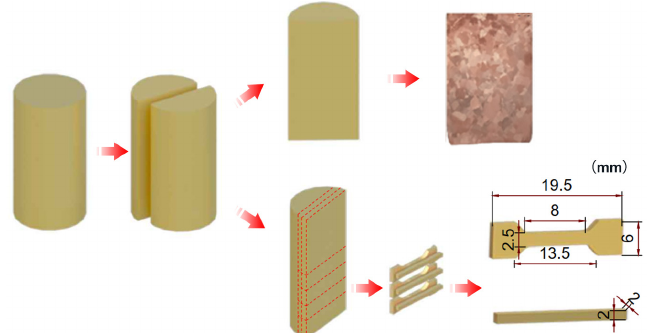
Figure 2. Schematic geometry of grain size characterization, electrical conductivity, and tensile testing specimen.